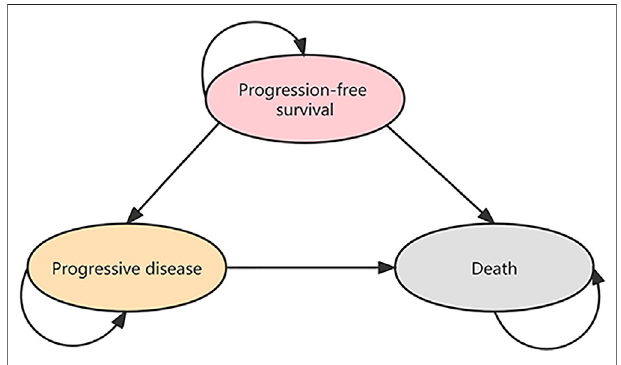
FIGURE 1 | Model Structure for cost – effectiveness